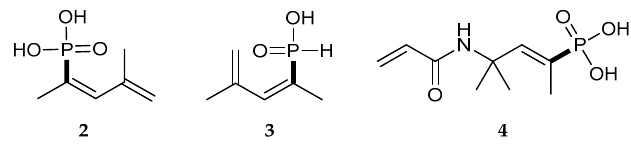
Figure 2. Chemical structures of 2 , 3 and 4 .